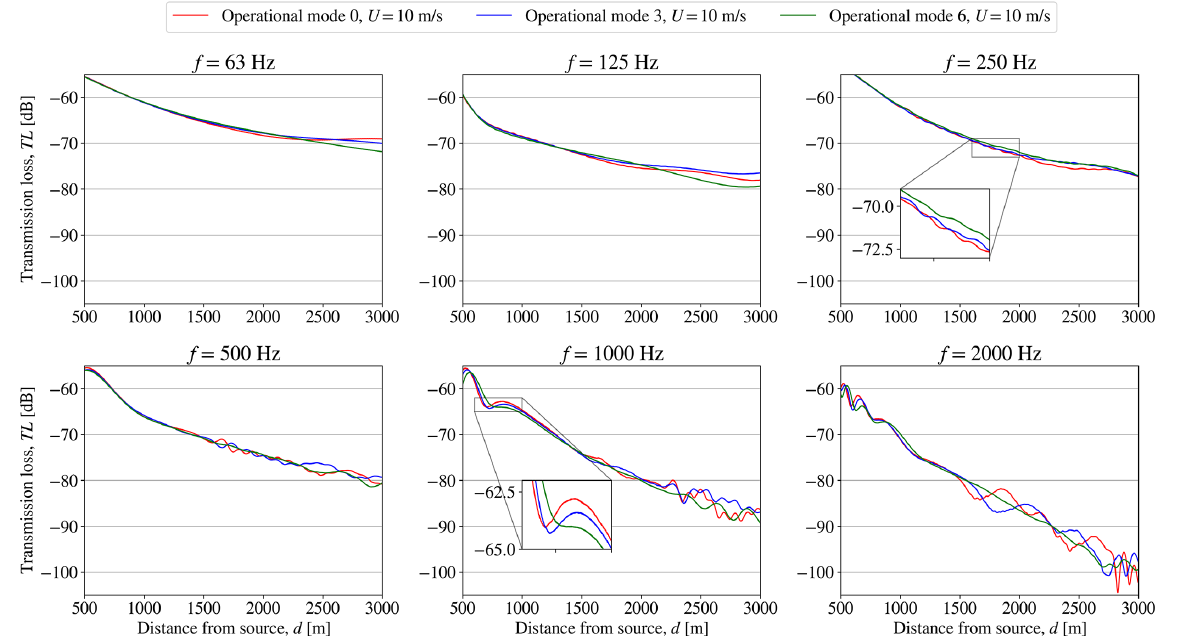
Figure 5. Setup 1: the transmission loss, TL, obtained from WindSTAR computations from a single SWT-DD-142 wind turbine subject to changing operational modes at each octave band frequency at a free field wind speed of U hub = 10ms − 1 at hub